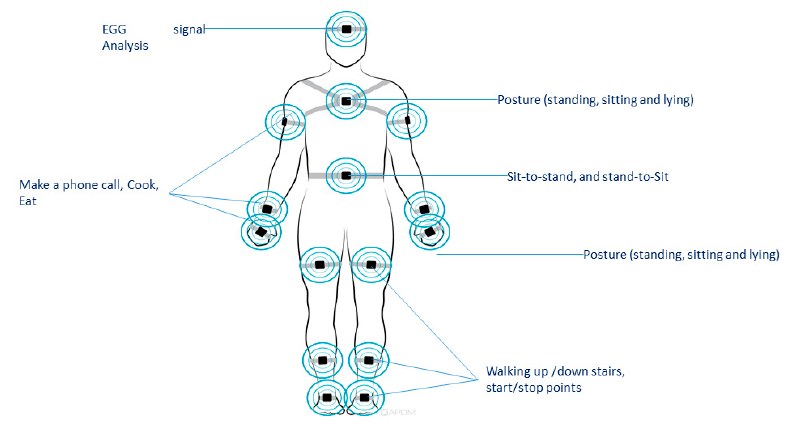
Figure 7. Body sensor representation related to ADL.